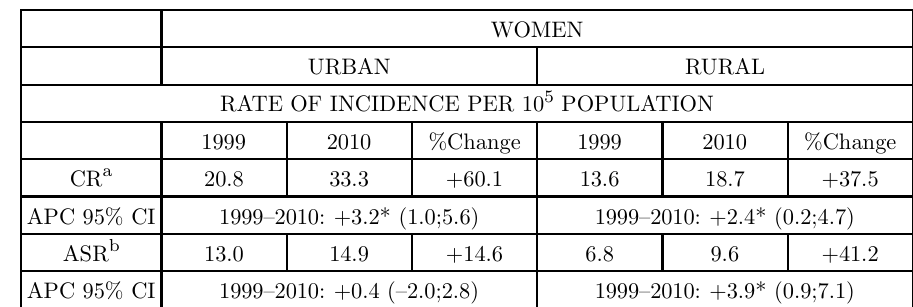
Table 2. Rates of incidence, mortality, and PYLL of lung cancer and their trends from 1999–2010 in the urban and rural areas of the